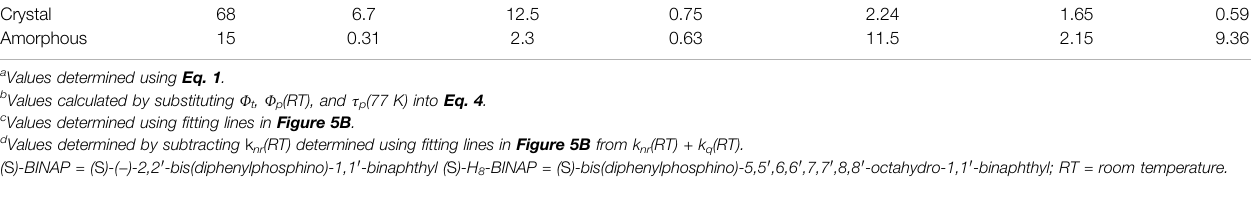
Because 0.3 wt% ( S )-BINAP doped into β -estradiol had an Φ p (RT) of 0.052 and a